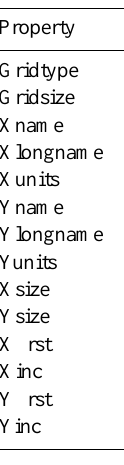
Table 2. Properties of the grid